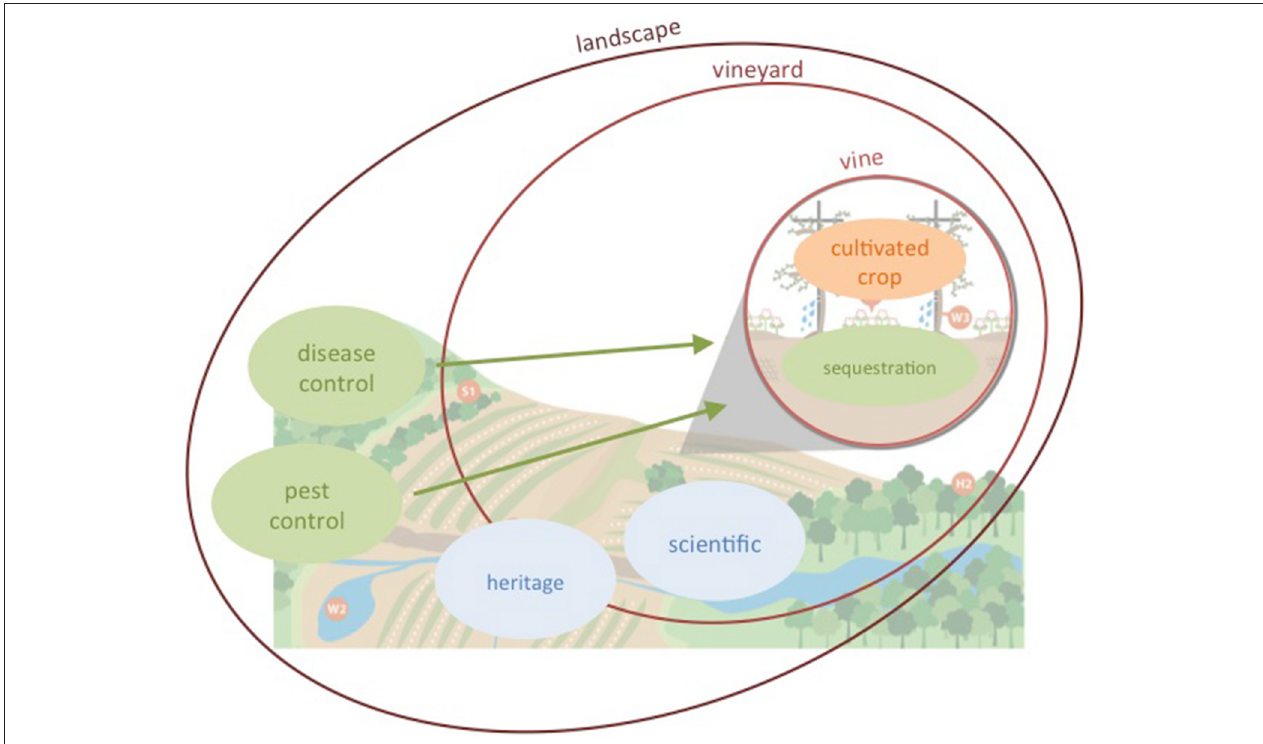
FIGURE 5 | Multifunctional vineyard system showing some relationships between the six key ecosystem services we identified (see text). The scale of ecosystem service provision varies from the vine, to the vineyard, to the surrounding vineyard landscape. (Underlying graphic from Viers et al., 2013; used with